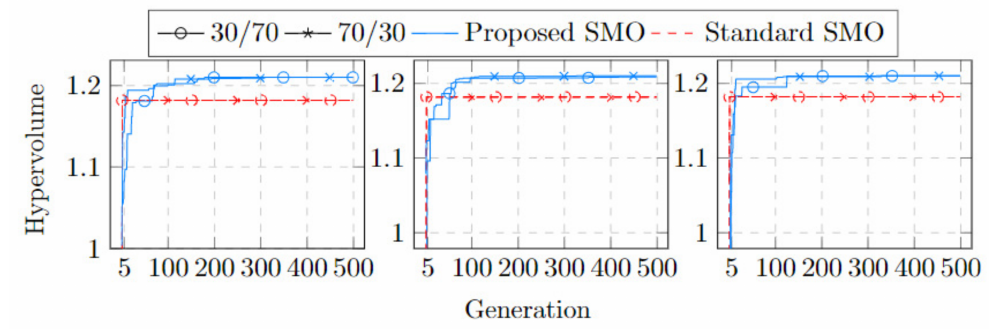
Figure 8. Convergence rate plots of the standard and proposed SMO approaches for the scenarios with 7 operators (left-hand side), 8 operators (center), and 9 operators (right-hand side).